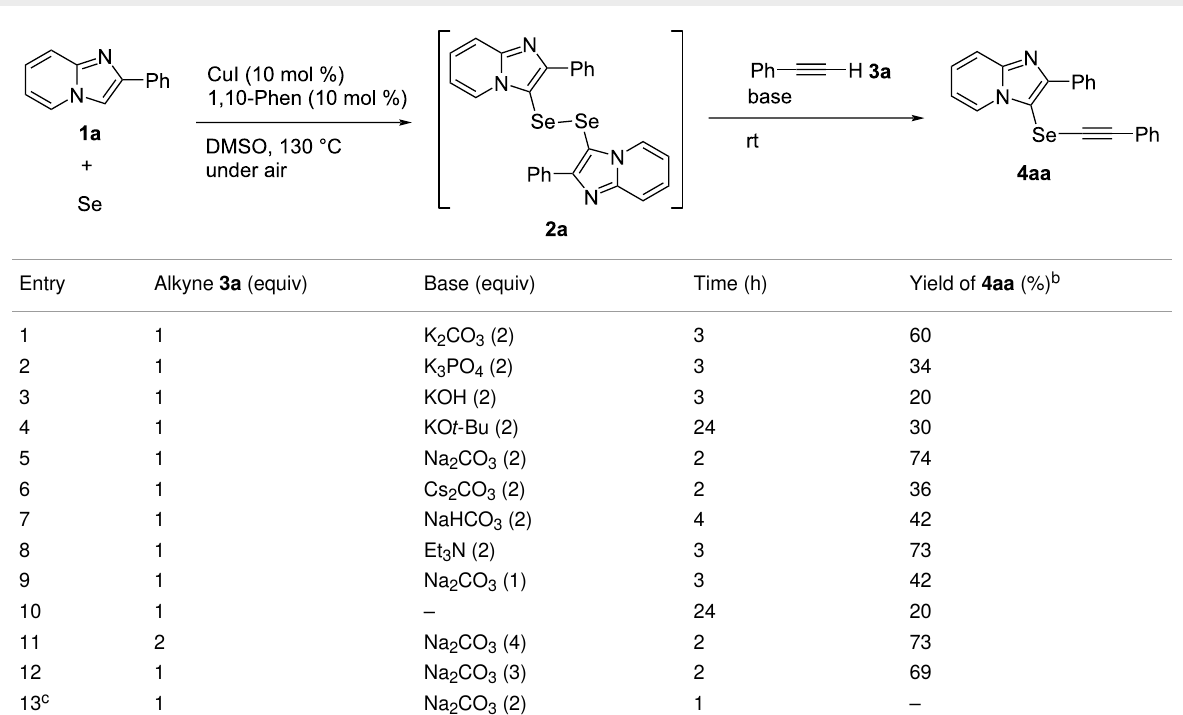
Table 1: One-pot reaction of Se powder with 1a and 3a a